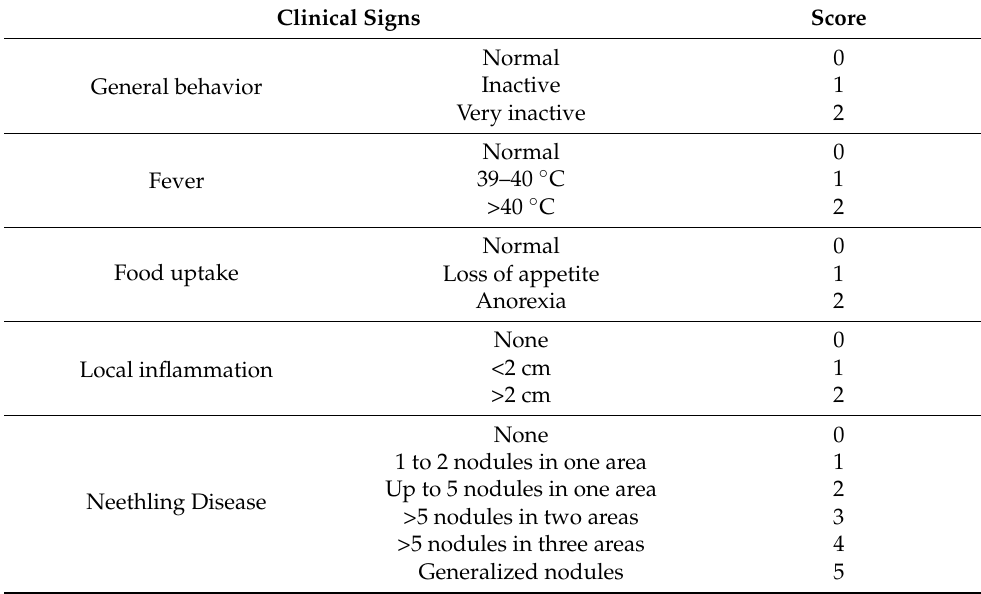
Table 1. Scoring of recorded clinical